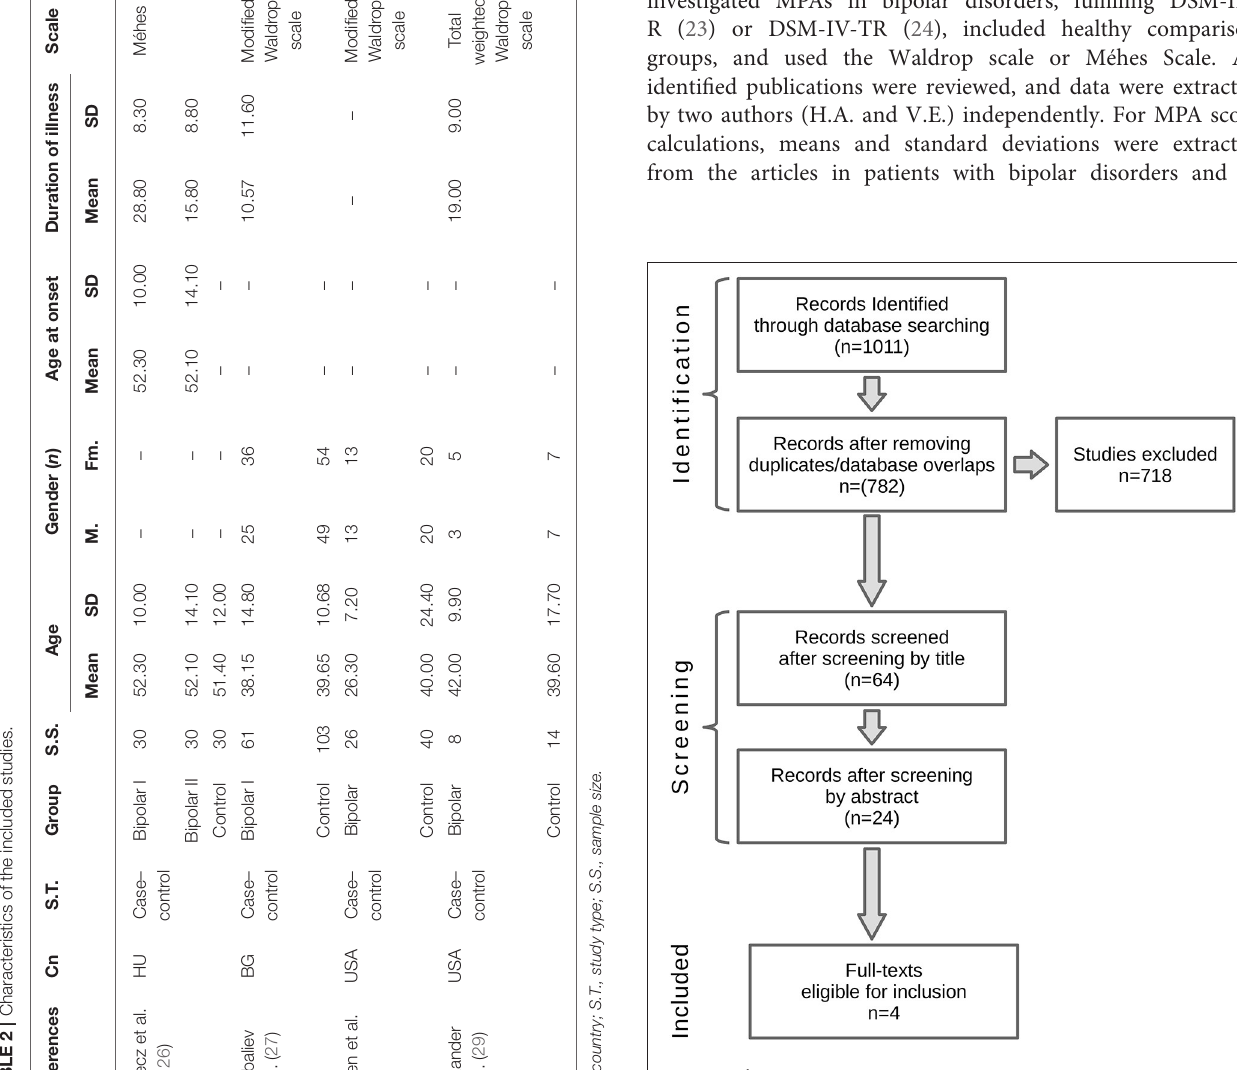
FIGURE 1 | Flowchart of the study selection